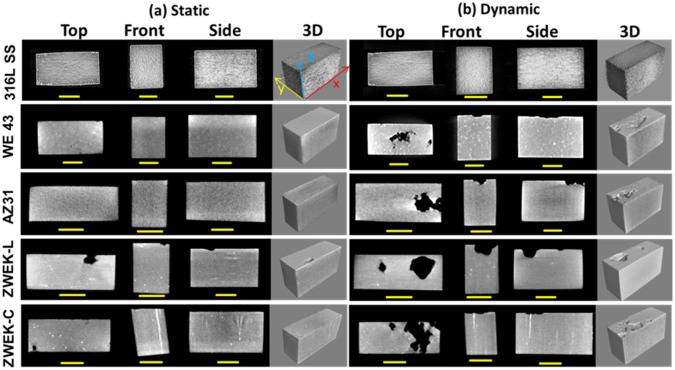
Micro-CT images of selected cross-sections morphology and 3D view.The cross- section view of the top is XY plane, the front is YZ plane, the side is XZ plane. The degraded alloys were tested at both static (a) and dynamic (b) conditions after removing corrosion product by chromic acid. Scale bar = 1.5mm.